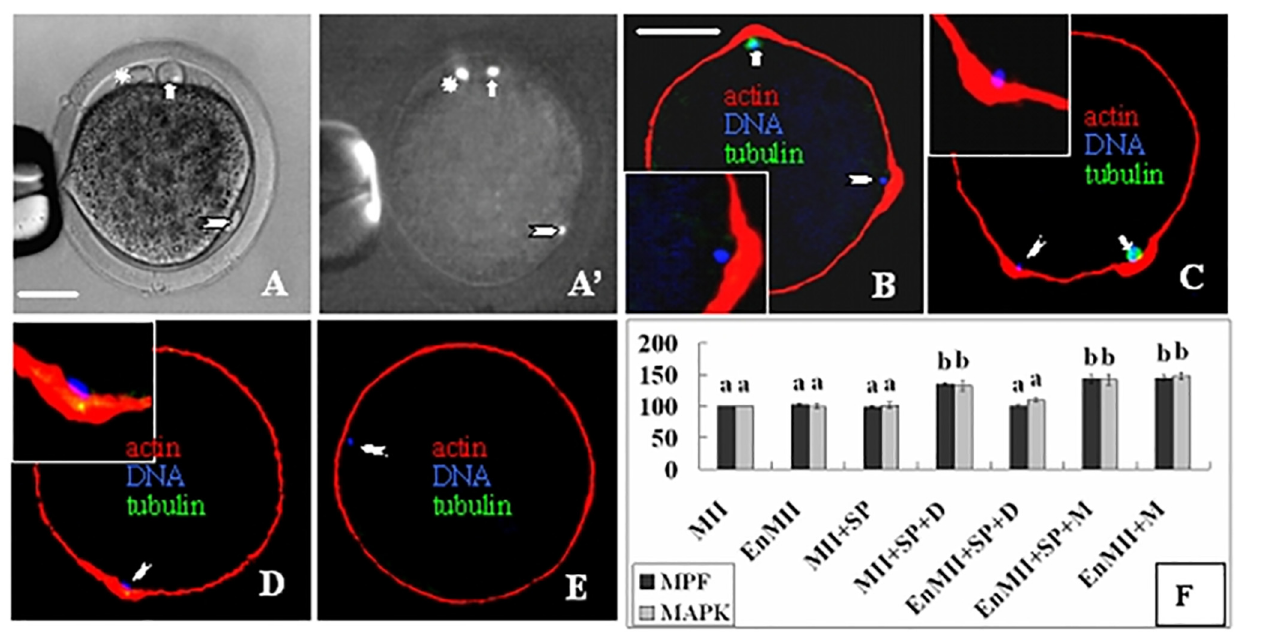
Fig 2. An example biomedical figure with a complex layout, color text, and irregular text